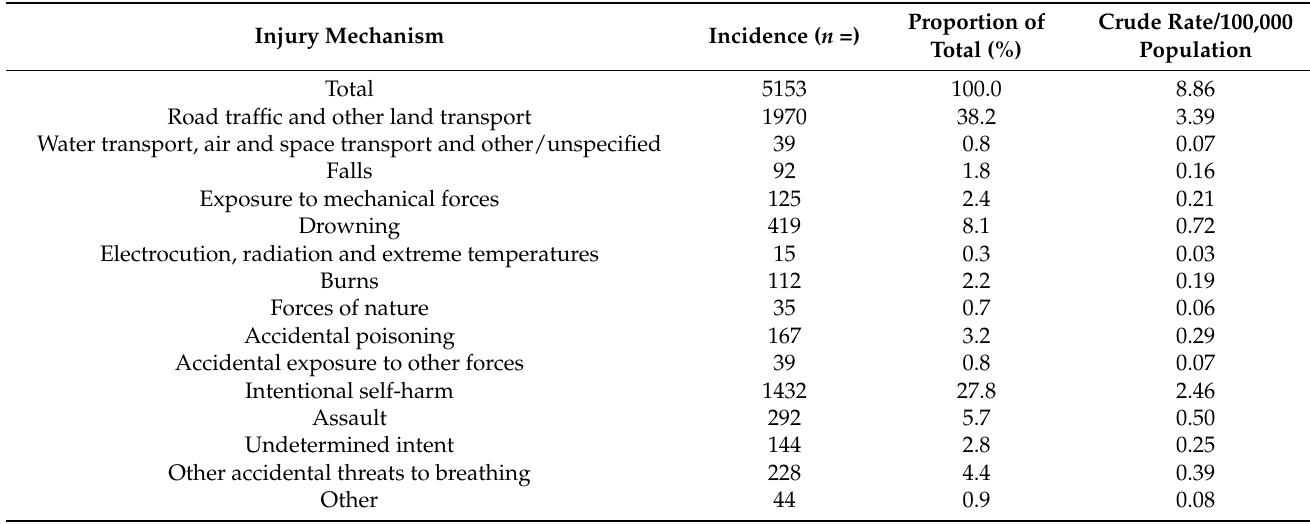
Table 2. Incidence of injury-related fatality by mechanism, proportion of total and crude rate per 100,000 population among children and adolescents 0–19 years of age, Australia, 2007-08–2016-17.